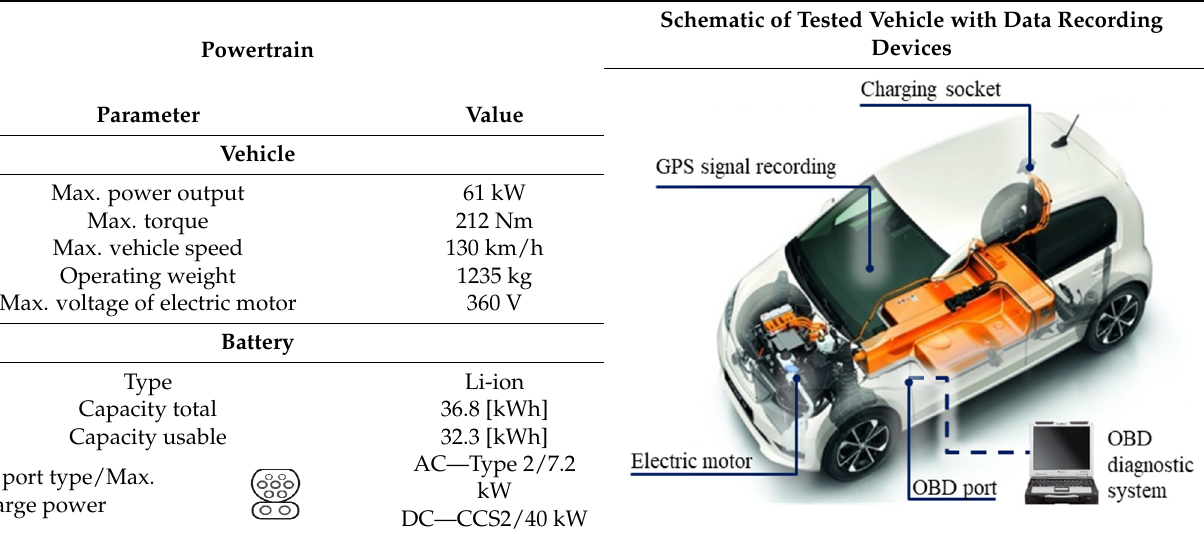
Table 2. Technical data of the analyzed powertrain fitted in ŠKODA CITIGO e iV [51].